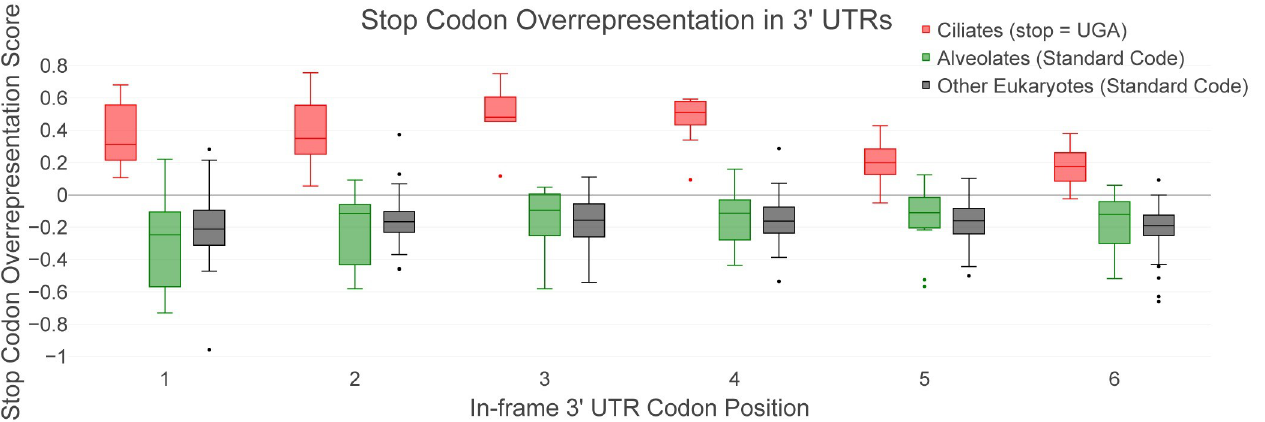
Fig 1. Box-plot comparing SCO scores in 3’ UTRs across species. The SCO scores for each in-frame position of their 3’ UTRs was calculated for each of 81 organisms. The scores are plotted at each of the first 6 in-frame positions of their 3’ UTRs and grouped in the following manner: 9 ciliates with the UAR stop codons reassigned to Gln (red), 12 standard code non-ciliate alveolates (green), and 60 standard code non-alveolate eukaryotes (black). Box plots are used to represent combined SCOs from all species in each grouping at each in-frame codon position in the 3’ UTR, with whiskers extending to a maximum of 1.5 interquartile range, the edges of the boxes at Q1 and Q3, and the central line indicating the median SCO at that position. Scores outside the whiskers’ range are shown as points.